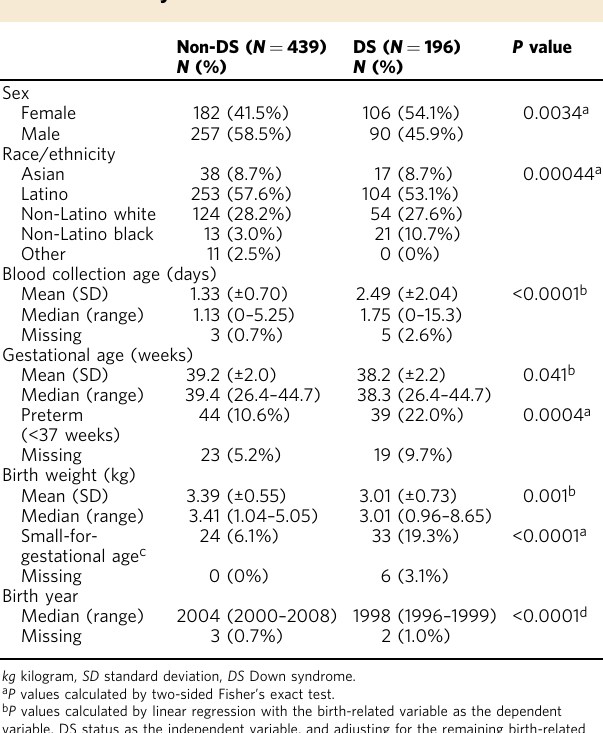
Table 1 Baseline characteristics of newborns with and without Down syndrome included in our epigenome-wide association